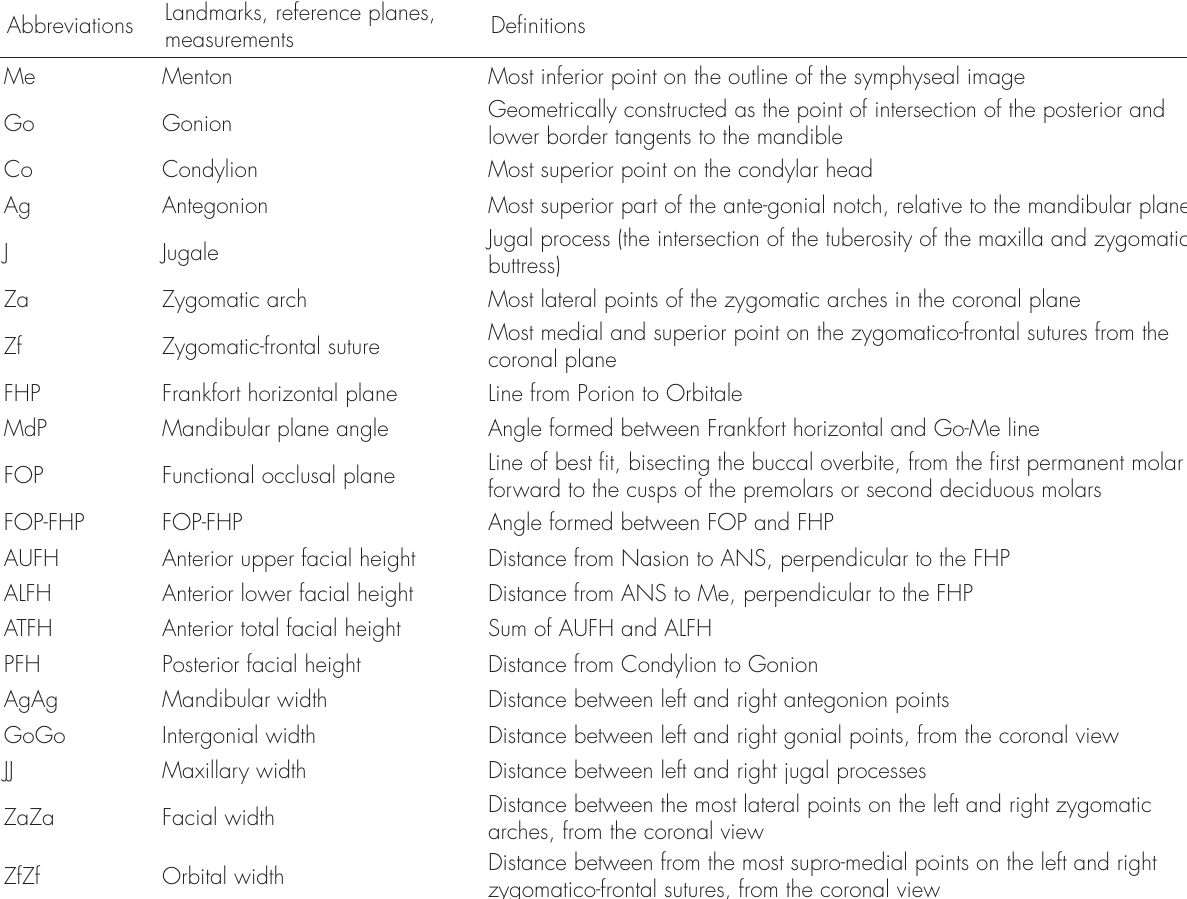
Table I. Landmarks and reference planes used in this study.